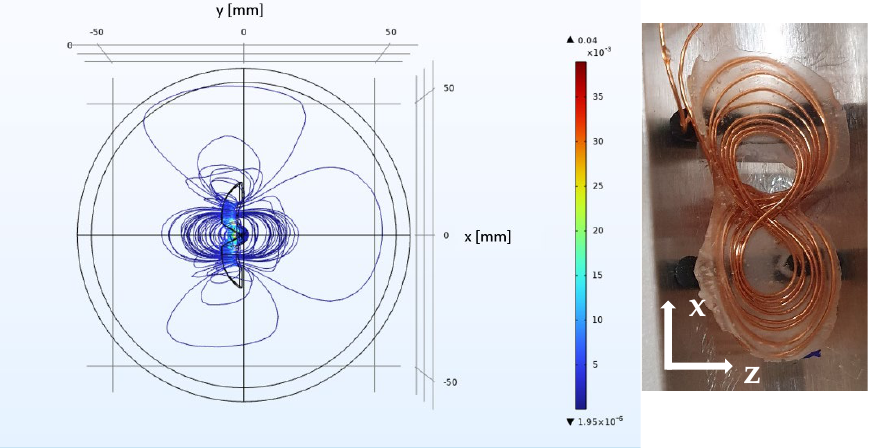
Figure 3. ( Left ): Simulation of | B 1 ( r )| of the homogenized bent figure-8 coil. The coils geometry is